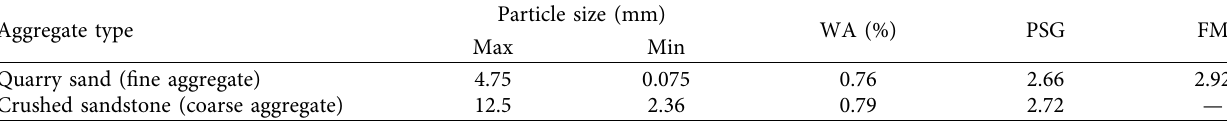
Table 2: Engineering characteristics of aggregates used in this research.